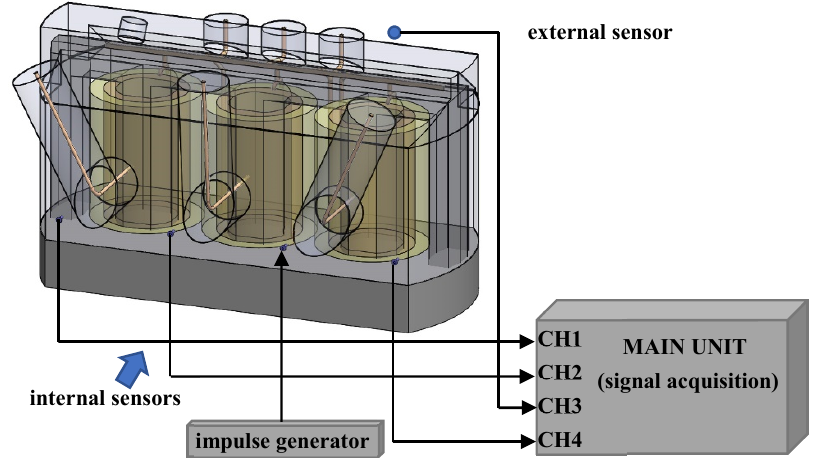
Figure 20. External sensor configuration (utilized within the DDA mode).